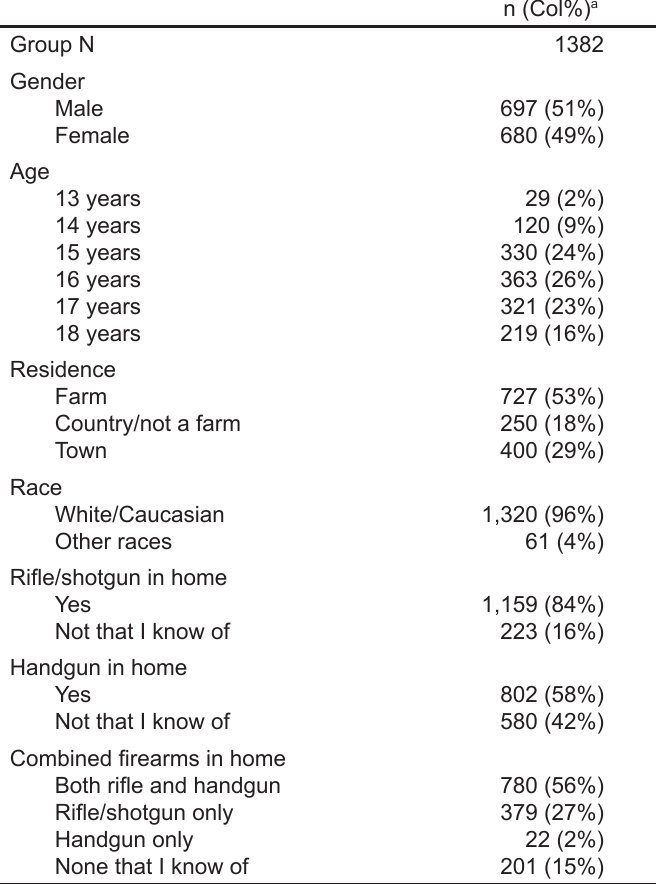
Table 1. Demographic and firearm-related variables of adolescent survey